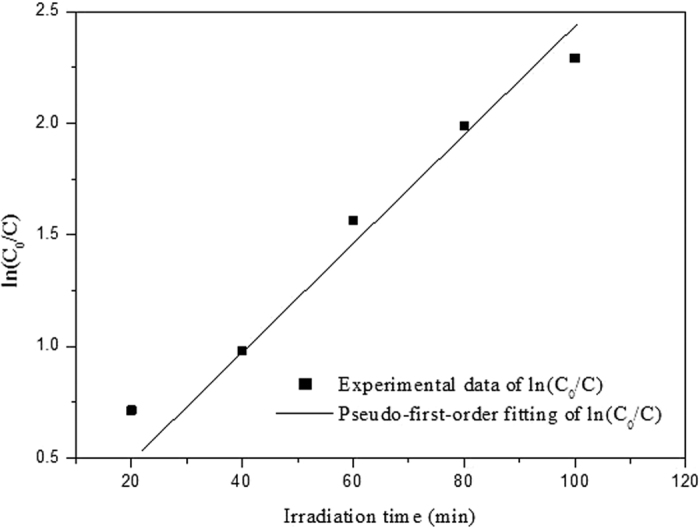
Pseudo-first-order kinetic fitting for photocatalytic degradation of MO by the C-S NPC@Cu2O NNs.